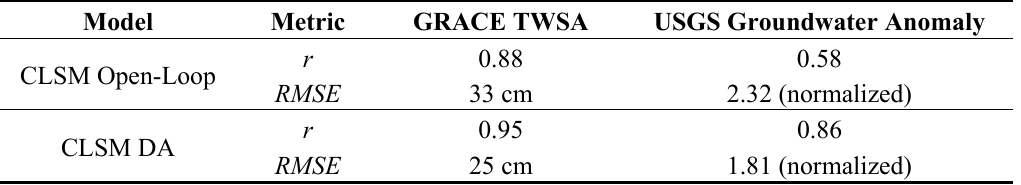
Figure 4. ( a ) The effect of assimilation on Terrestrial Water Storage in the Northern Plains domain, showing the region-averaged GRACE TWSA, the open-loop model (CLSM), and the GRACE-assimilated model (CLSMDA); ( b ) well validation for the Northern Plains region, showing the groundwater component only from the open-loop model (CLSM), the GRACE-assimilated model (CLMSDA), and independent well observations averaged over the region (climatology removed in each). Table 1. Goodness of fit statistics for assimilation effects and validation of assimilation improvement of domain-averaged groundwater state estimation with well observations. All statistics are significant at the 95% confidence